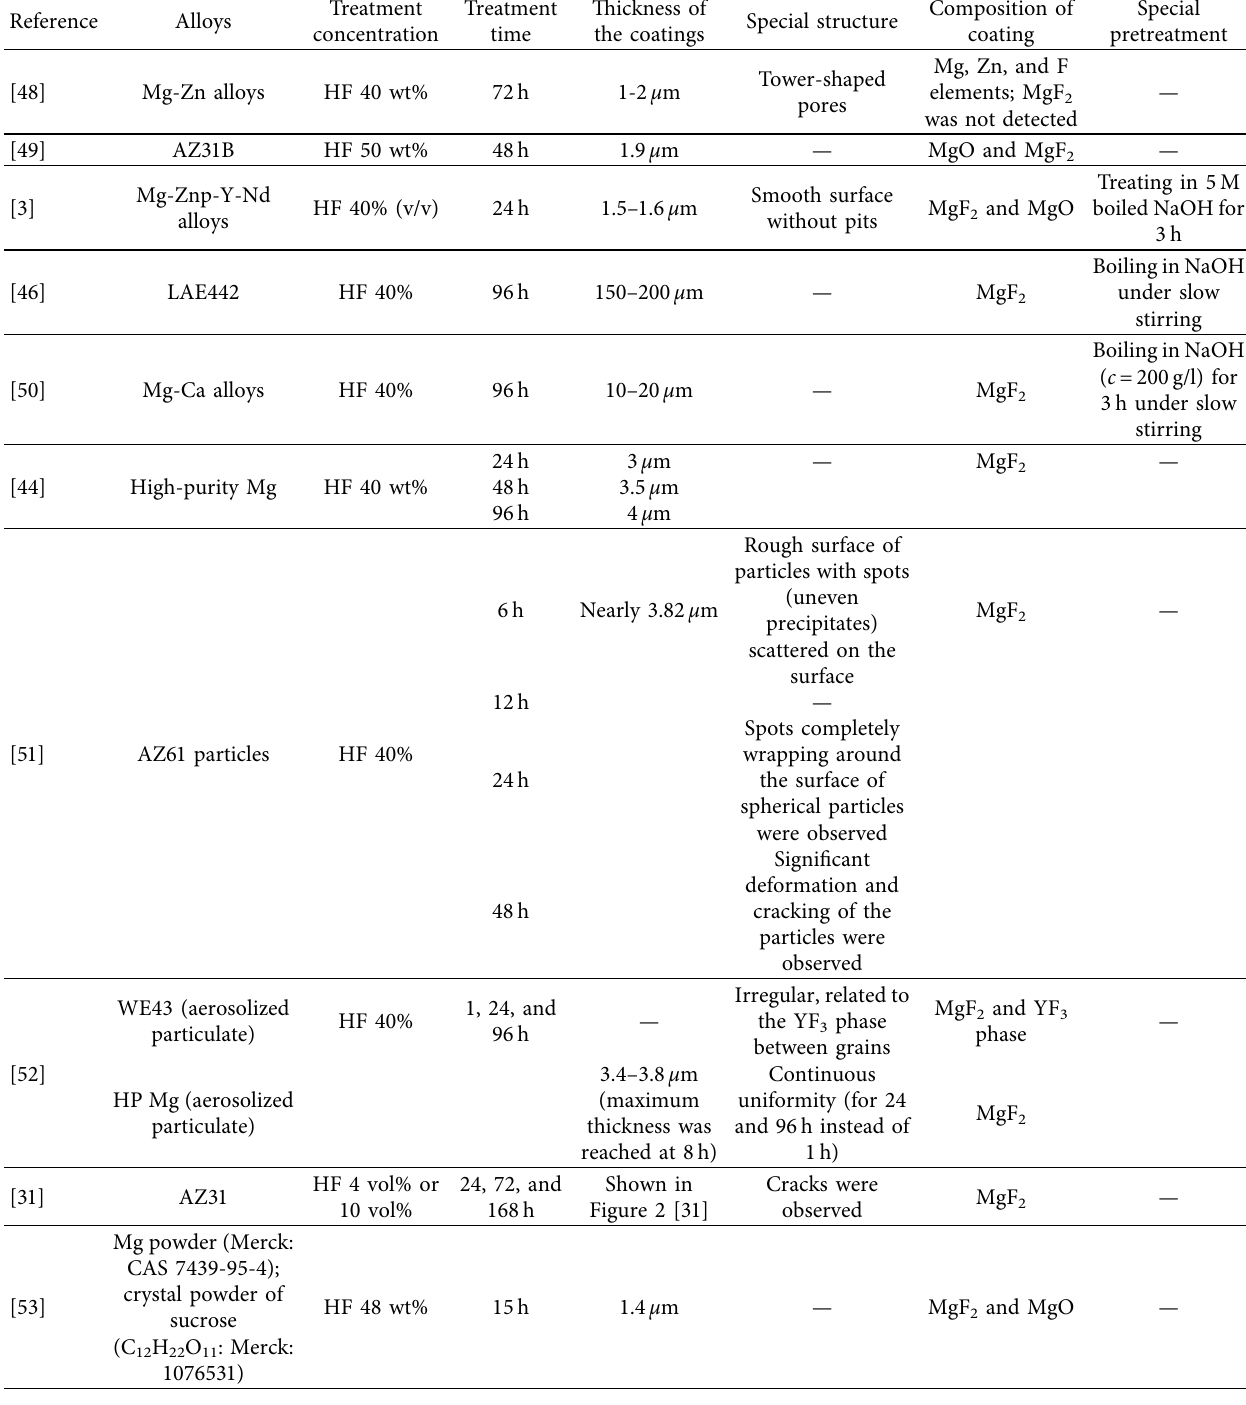
Table 1: Characteristics of different HF-coated magnesium alloys prepared under various